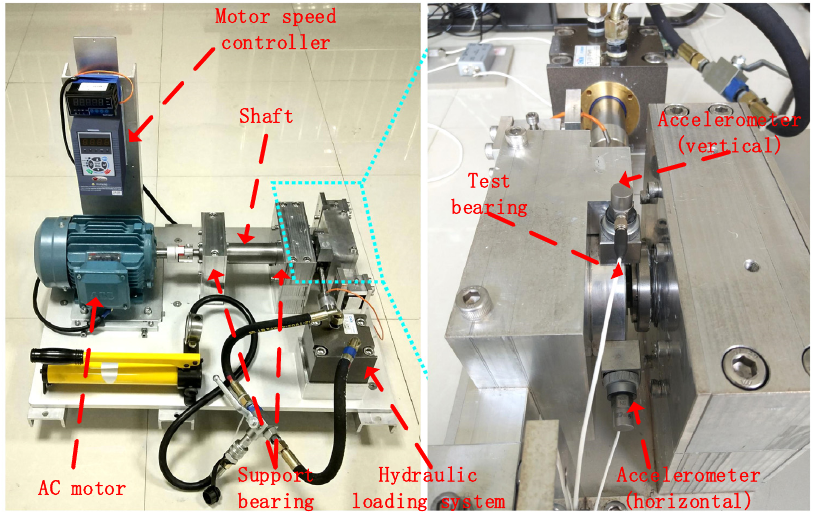
Figure 14. XJTU-SY bearing accelerated life test bench.